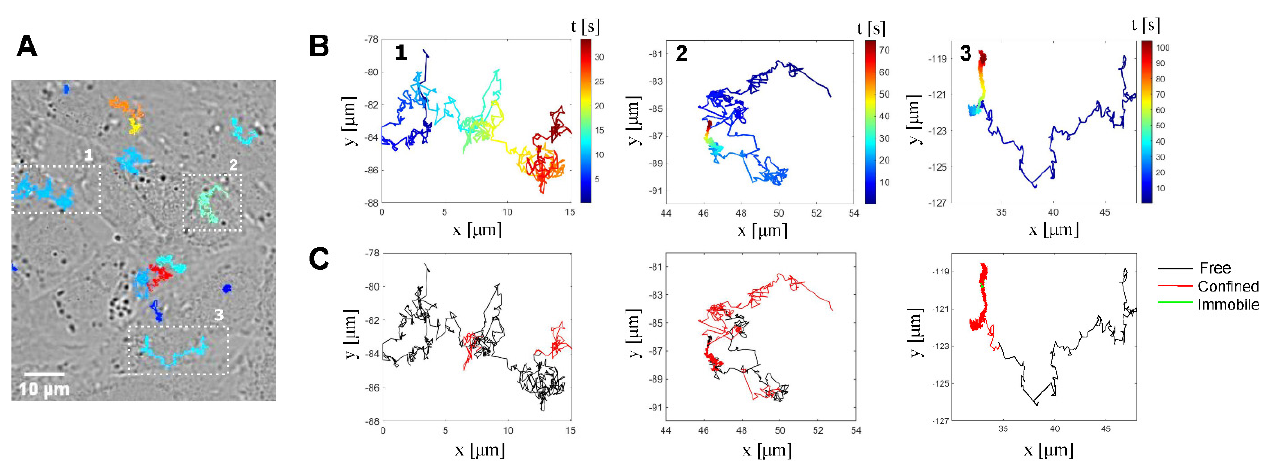
Figure 1. Single particle tracking. ( A ) Overlay of a differential interference contrast (DIC) image of CHO cells and fluorescence image of SP-DIO-labeled HSV-1 particles captured immediately before recording the virus movement (corresponding Movie S1A with maximum projection of a 120 s time-lapse sequence acquired at 25 fps). ( B ) Full tracks of three representative tracks (1 − 2 − 3) of viruses landing on the cell surface extracted with Trackmate. The associated movie is shown in Movie S1E. ( C ) Segmentation of the representative tracks shown in B and classification of segments using moment scaling spectrum (black: Brownian free motion—red: restricted confined motion—green: immobile).